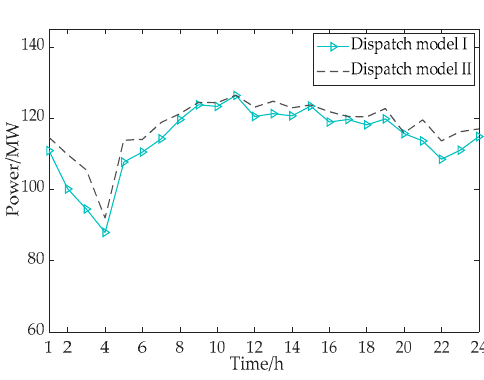
Figure 13. Comparison of demand response (DR).